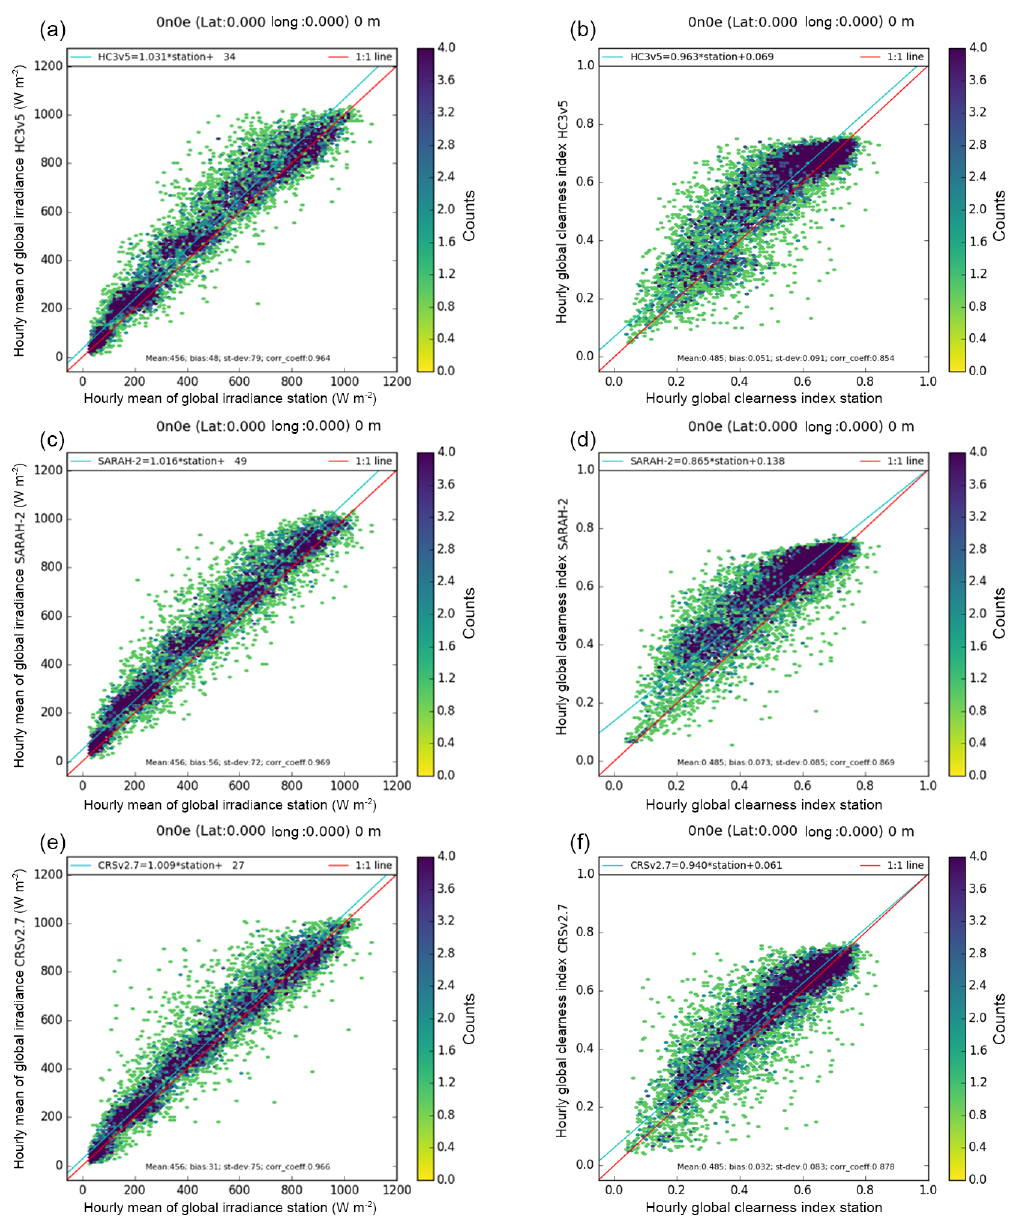
Figure A1. The 2-D histograms of PIRATA measurements (horizontal axis) and data sets (vertical axis) at 0 ◦ N, 0 ◦ E for E and KT. HC3v5: (a) and (b) ; SARAH-2: (c) and (d) ; CRS: (e) and (f) . Ideally, the dots should lie along the red line (1:1 line). The blue line is the affine function fitted over the points and should ideally overlay the red